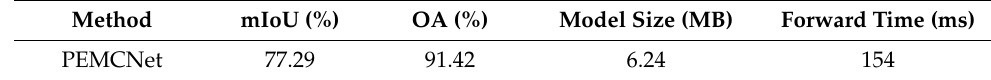
Figure 6. ( a ) Point cloud data with RGB information. ( b ) The classification results of PEMCNet on the test set of the GDUT-S3D dataset. Table 5. Quantitative classification performance of PEMCNet on the test set of GDUT-S3D dataset.